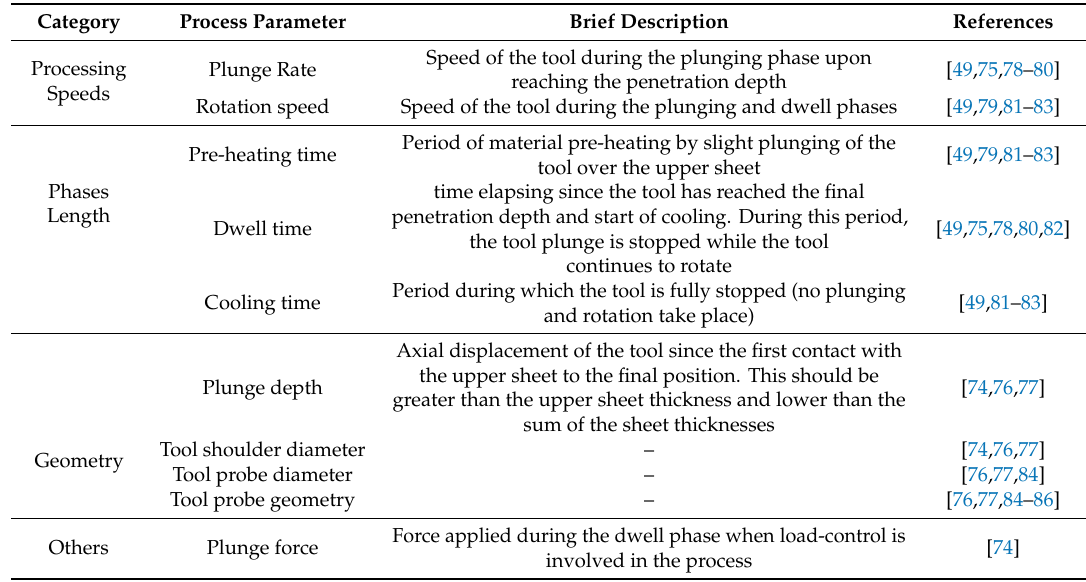
Table 5. Classification of process parameters for